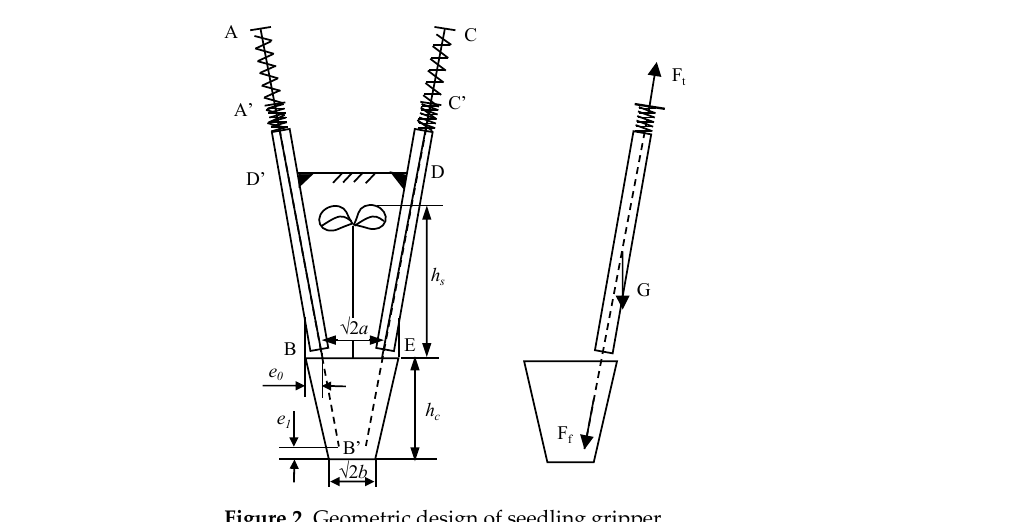
Figure 2. Geometric design of seedling